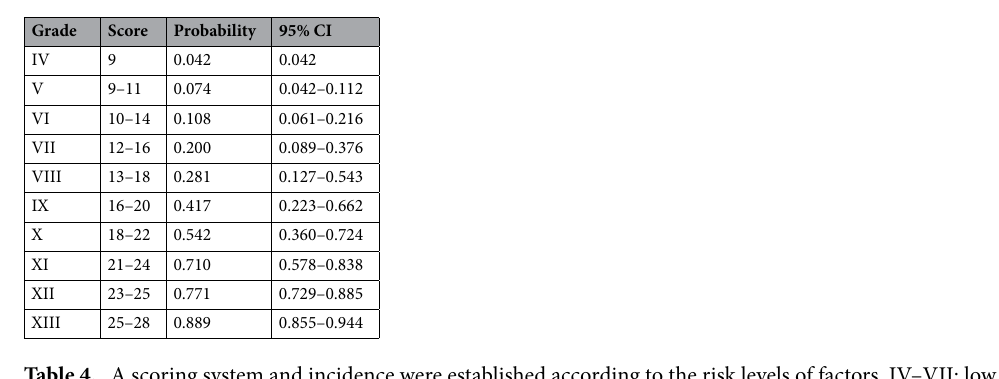
Table 4. A scoring system and incidence were established according to the risk levels of factors. IV–VII: low risk; VIII–X: intermediate risk, XI–XIII: high risk, CI Confidence